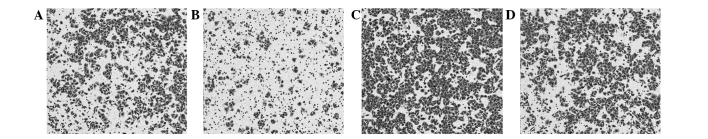
Cell invasion ability of SGC-7901 cells by Transwell® assay. Visual fields (n=15) of each insert were randomly counted under a microscope (magnification, ×200). The results showed that the invasion cell number in the miR-32-mimic group was significantly less than that of the other groups (P<0.05). (A) miR-32-inhibitor, (B) miR-32-mimic, (C) untreated and (D) empty vector control groups. miR-32, microRNA-32.